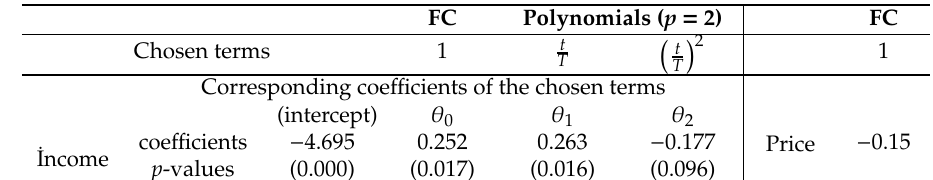
Table 4. Long-run estimation results.